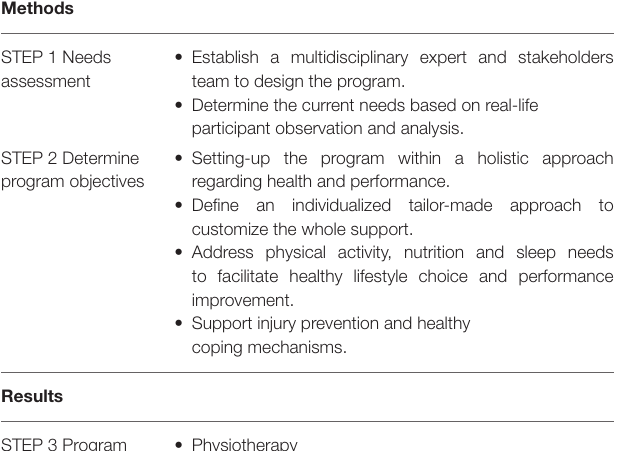
TABLE 1 | Overview of the four first steps of the Intervention Mapping methodology applied to the current project